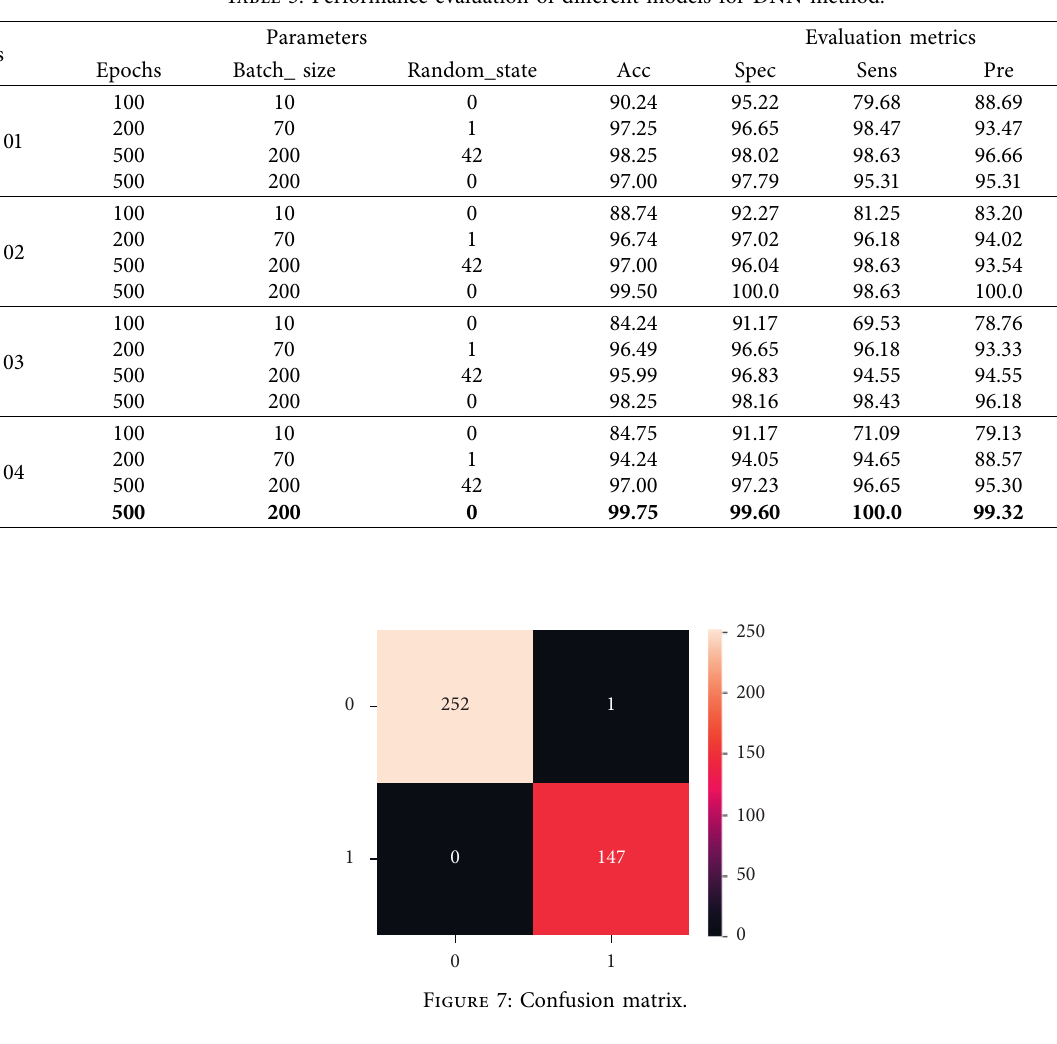
Table 5: Performance evaluation of different models for DNN method.